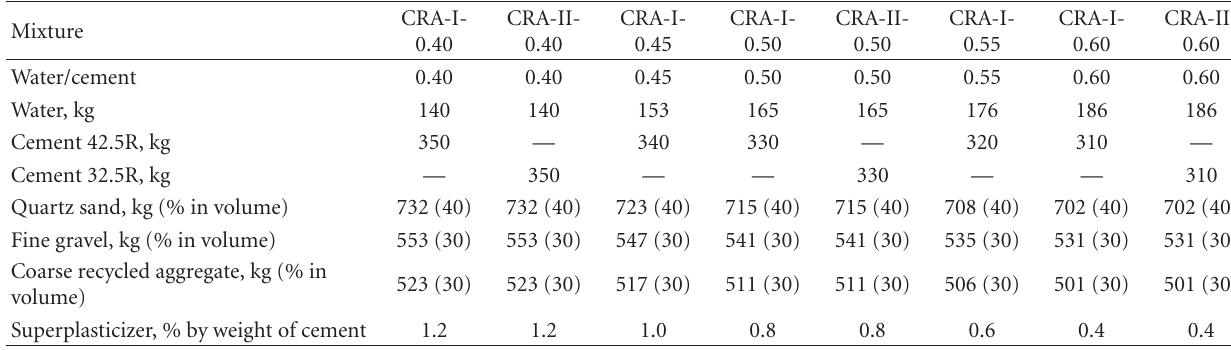
Table 3: Mixture proportions of concretes made of 30% coarse recycled aggregates.